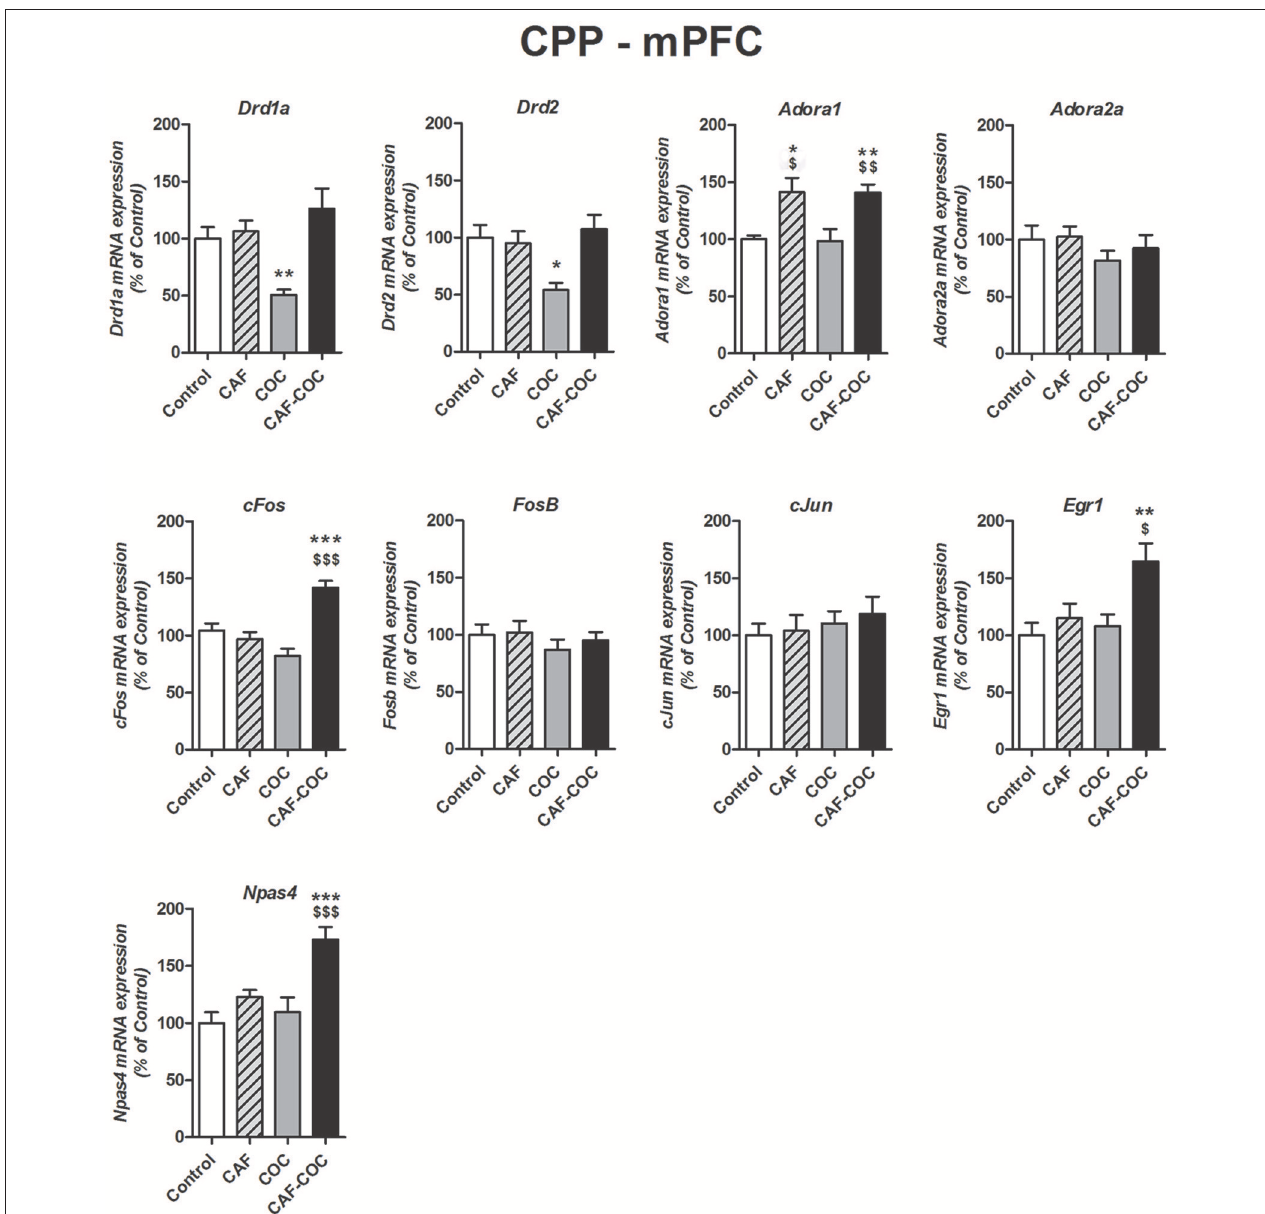
FIGURE 3 | Gene expression changes induced in the mPFC by caffeine and cocaine-associated memory retrieval in the CPP. Dopamine receptor subunits Drd1a and Drd2 ; adenosine receptor subunits Adora1 and Adora2 a; IEGs FosB , cFos , cJun , Egr1 , Npas4 . The values indicate mean ± SEM. One-way